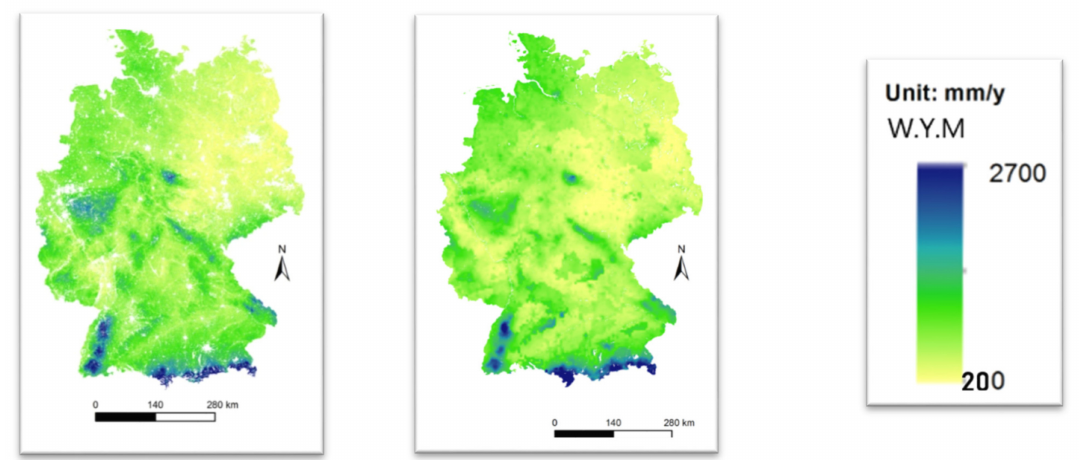
Figure 3. ( left ) InVEST water yield model (WYM)—resolution 250 m, ( right ) JRC water yield reference map from LISFLOOD model—resolution 5 km.